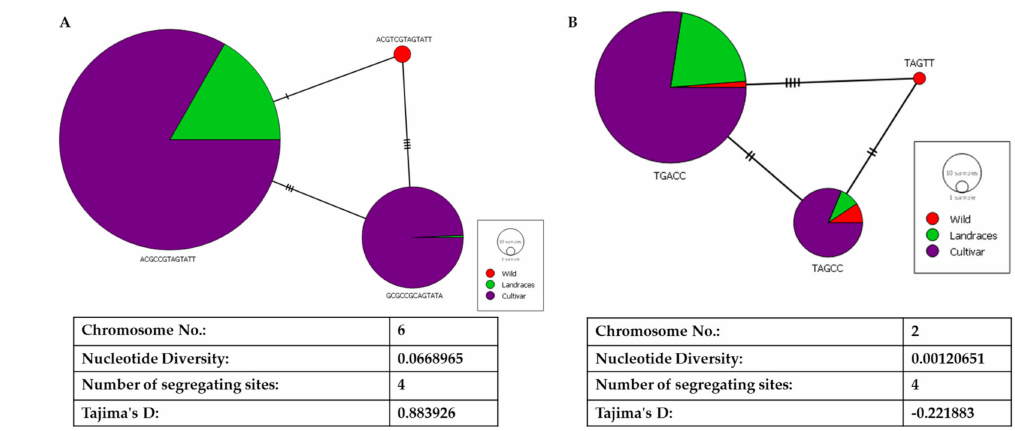
Figure 7. Haplotyping and network analysis of ( A ) acetolactate synthase and ( B ) ferrochelatase on chromosomes 6 and 2,